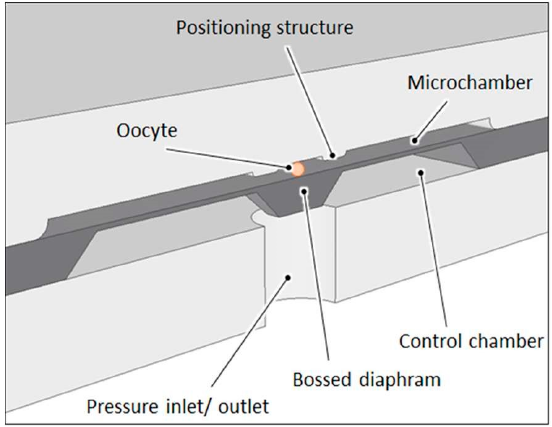
Figure 2. Schematic cross section through the microcytometer structure with trapped